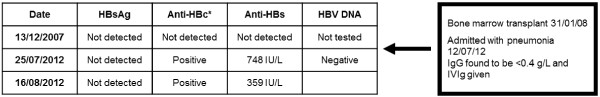
Timeline of events and serology results.*No absolute titre provided.